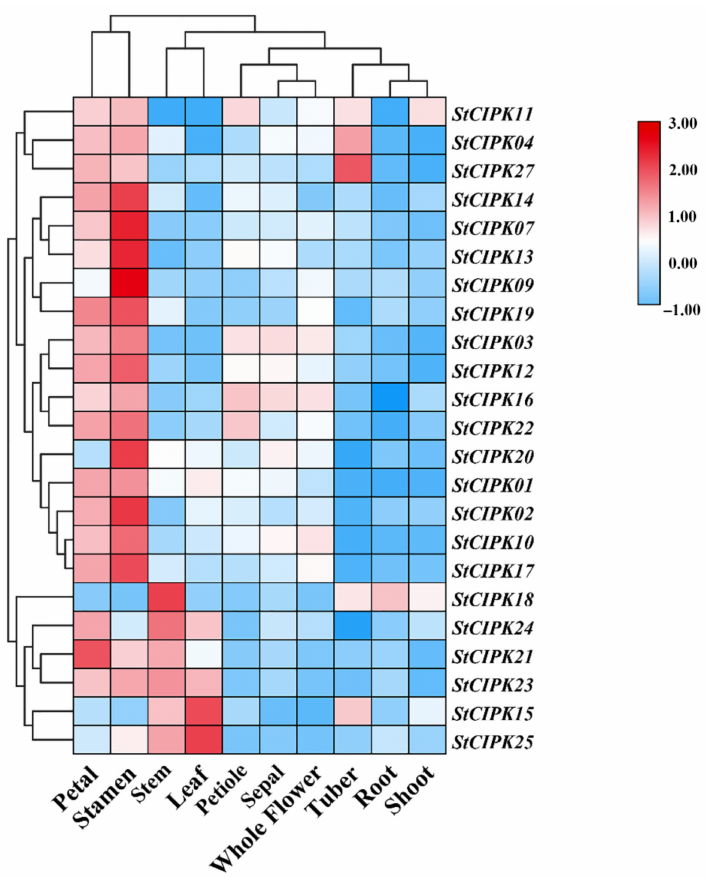
Figure 2. Heatmap showing the expression profiles of StCIPK genes in different tissues. Gene expression was analyzed by qRT-PCR. Three biological replicates, each containing three technical replicates, were conducted for each gene. Relative transcript levels were calculated using the comparative threshold (2 − ∆∆ CT ) method and normalized using